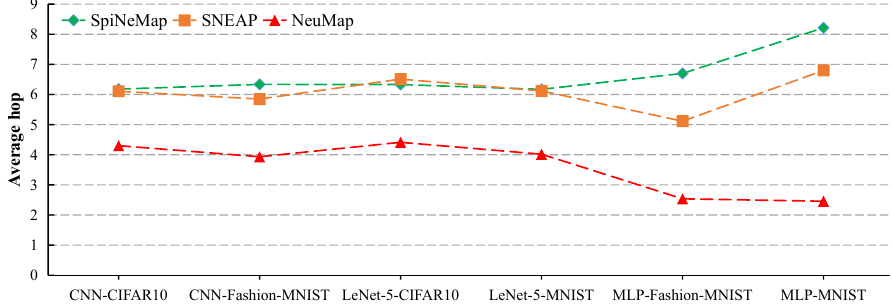
Figure 13. The average hop of spike messages.